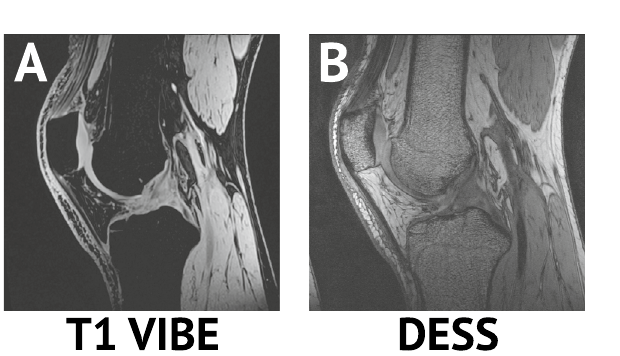
Figure 2. Sagittal ( A ) T1 VIBE and ( B ) DESS MR images were acquired of each human participant’s dominant knee. While DESS images have been reliably used for knee joint bone and cartilage model generation in the past, T1 VIBE had greater contrast between the bone and adjacent cartilage (0.95 vs. 0.72). DESS Double Echo Steady-State, T1 VIBE T1-weighted Volume-Interpolated Breathhold Examination with Water